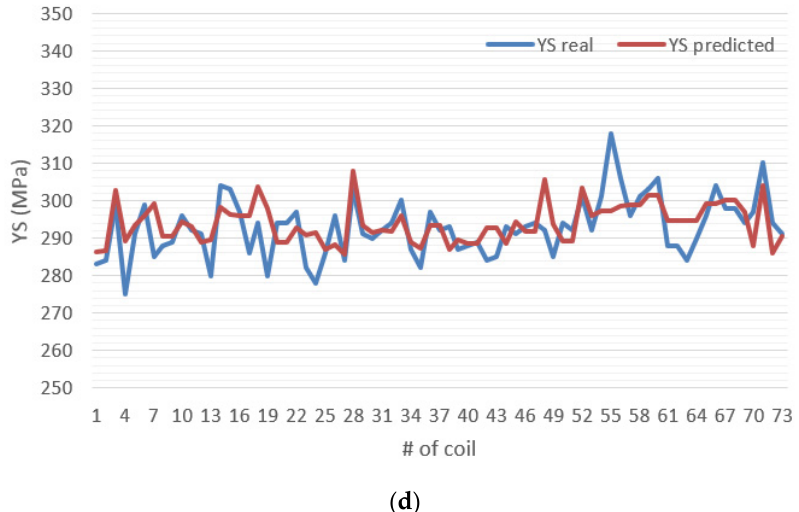
Figure 7. Plots of the real yield strength YS and the predicted YS calculated with the test dataset 2B for: ( a ) linear learner, ( b ) polynomial learner, ( c ) Neural Network learner, and ( d ) Multivariate Adaptive Regression Splines MARS learner. Table 8. Results of the di ff erent models and datasets for the prediction of ultimate tensile strength UTS. The minimum error values for each model and steel grade are marked in bold. Model